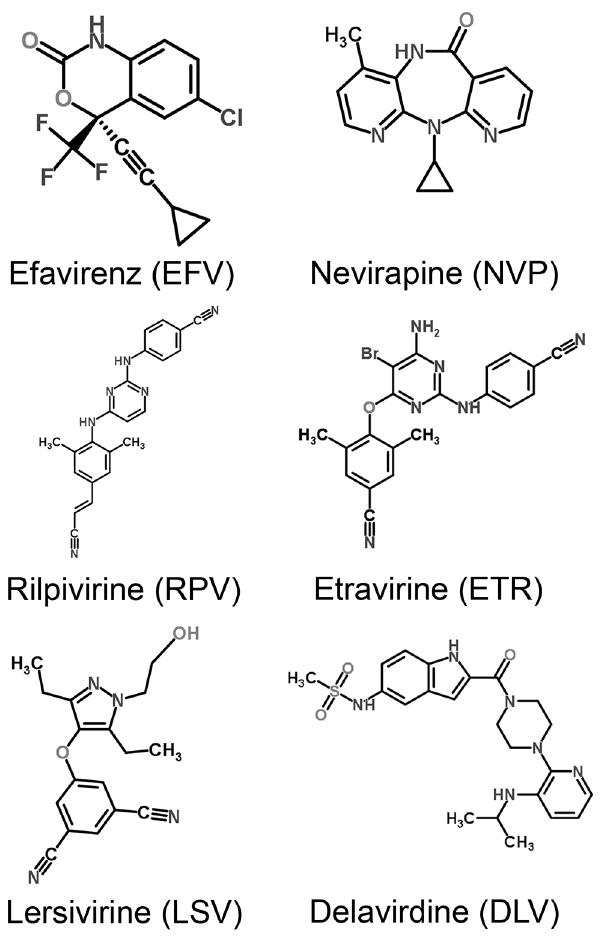
Fig 1. Chemical structures of the studied non-nucleoside reverse transcriptase